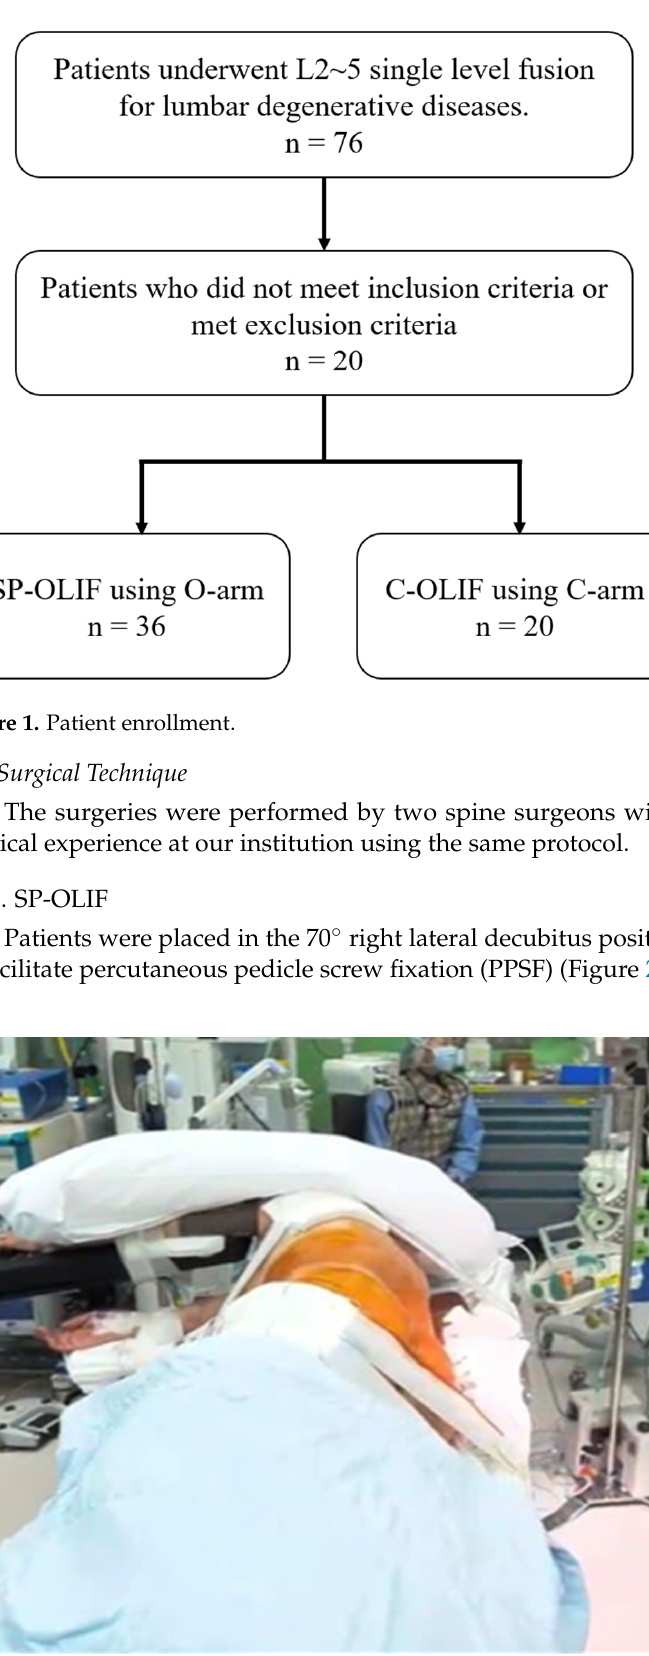
Figure 2. This is a figure. Schemes follow the same formatting. Intraoperative positioning of the Figure 2. Intraoperative positioning of the patient showing 70-degree right lateral decubitus (left patient showing 70-degree right lateral decubitus (left side up). side